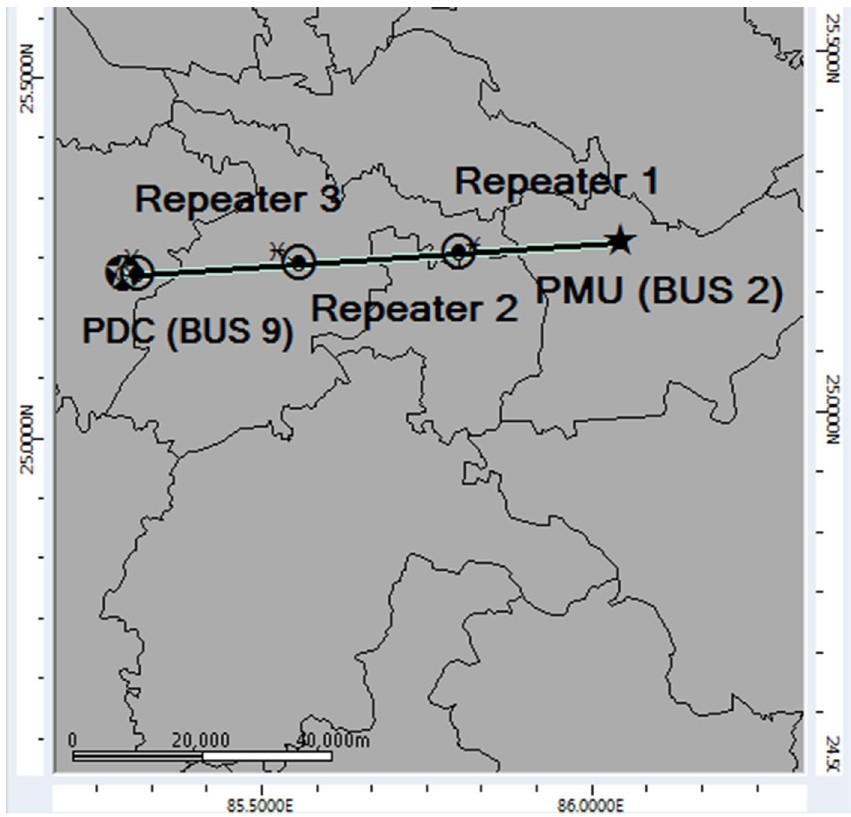
Fig. 8 The MSCS for the PMU located on bus 2 and the PDC located on bus 9 for the case